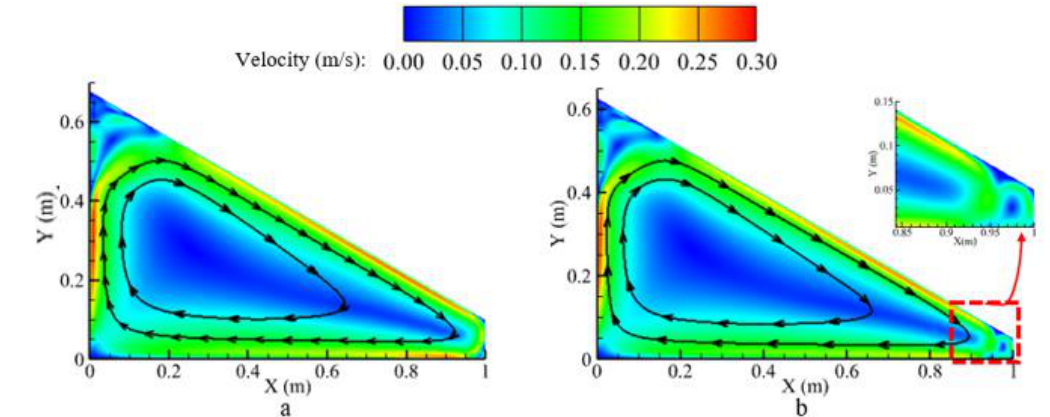
Figure 11. Streamlines at θ = 30°, ( a ) AR = 2.6, ( b ) AR = 2.9.